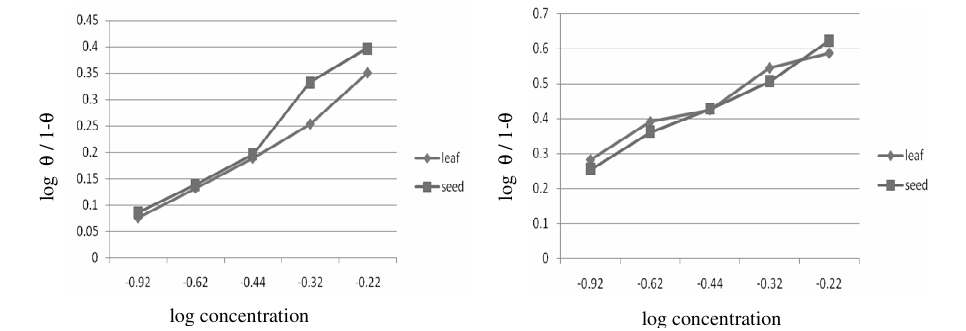
Figure 4 . Langmuir adsorption isotherm of leaves extract for aluminium in 1N HCl with inhibitor